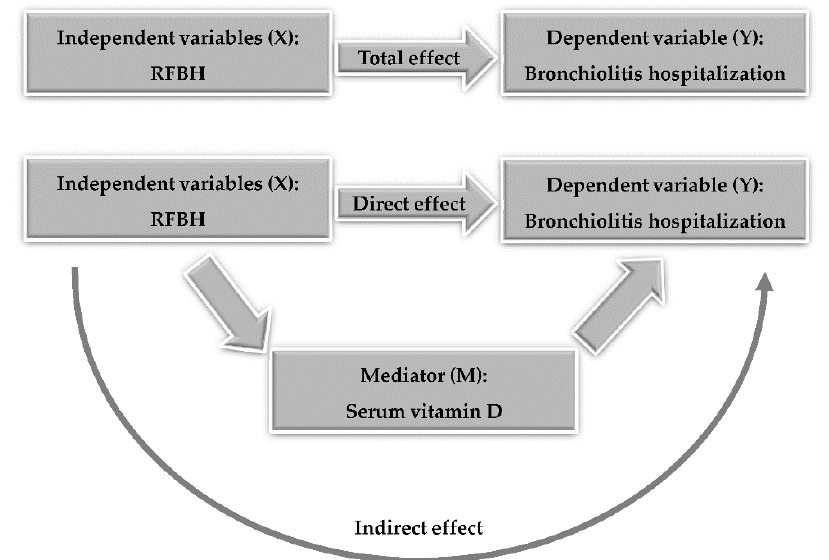
Figure 2. Mediation Analysis. Some X-Y association, that is, the “total effect”, is initially assessed. Then, a mediator M is introduced, and the aforementioned association may decrease, increase, or remain the same; this is referred to as the “direct effect”. The difference between the total and the direct effect is therefore to ascribe to an “indirect effect” of X on Y via M. RFBH: risk factors at birth and hospital admission.